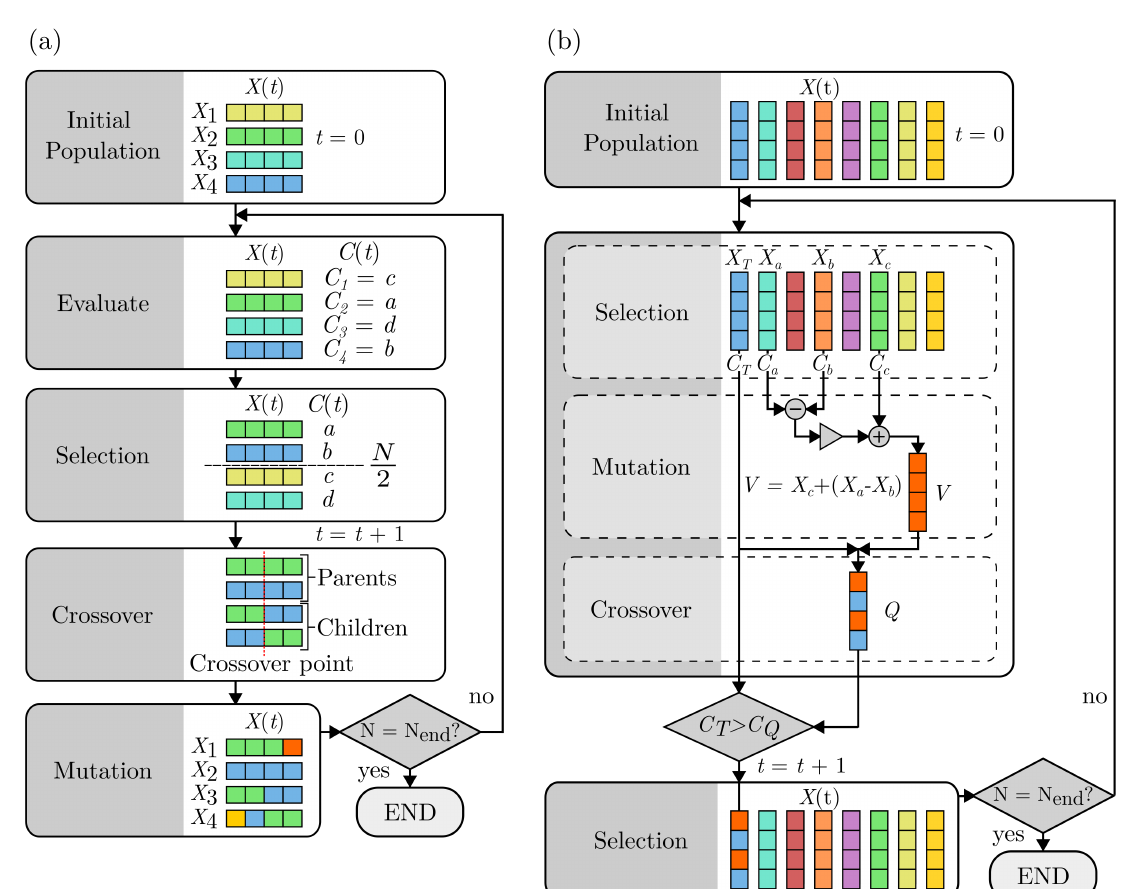
Figure 3. Two evolutionary algorithm processes. ( a , b ) share evolutionary elements of initial popula- tion formation, selection, crossover and mutation. For both algorithms, the initial population X ( t ) contains a population of N sets of parameter settings. The colour indicates each set of parameter settings. t , generation or loop number; t = t + 1, the next generation; and C ( t ) , measured cost. Both algorithms repeat until the end condition is met, where the number of sets of parameters tested N is equal to 250 ( N end ). ( a ) Genetic algorithm (GA) process. The initial population is generated and evaluated for cost, with individual costs denoted as C i . N parameter sets are selected for the 2 next generation based on ranked cost. The best performing N are used as “parents” to produce 2 “children” sets during crossover with respect to the crossover point. Mutation of individual parameter values randomly occurs in the new population. ( b ) Differential evolution (DE) process. The initial population is generated and evaluated for cost where three random sets X a , X b & X c and a target set X T are selected. A new set V is created during mutation from the randomly selected sets, and used in a crossover with the target set to make a new set Q . C Q , the cost of Q , is evaluated and measured against C T , the cost of the target set. The target set is replaced in a new generation if C Q > C T (for C 1 ) or C Q < C T (for C 2